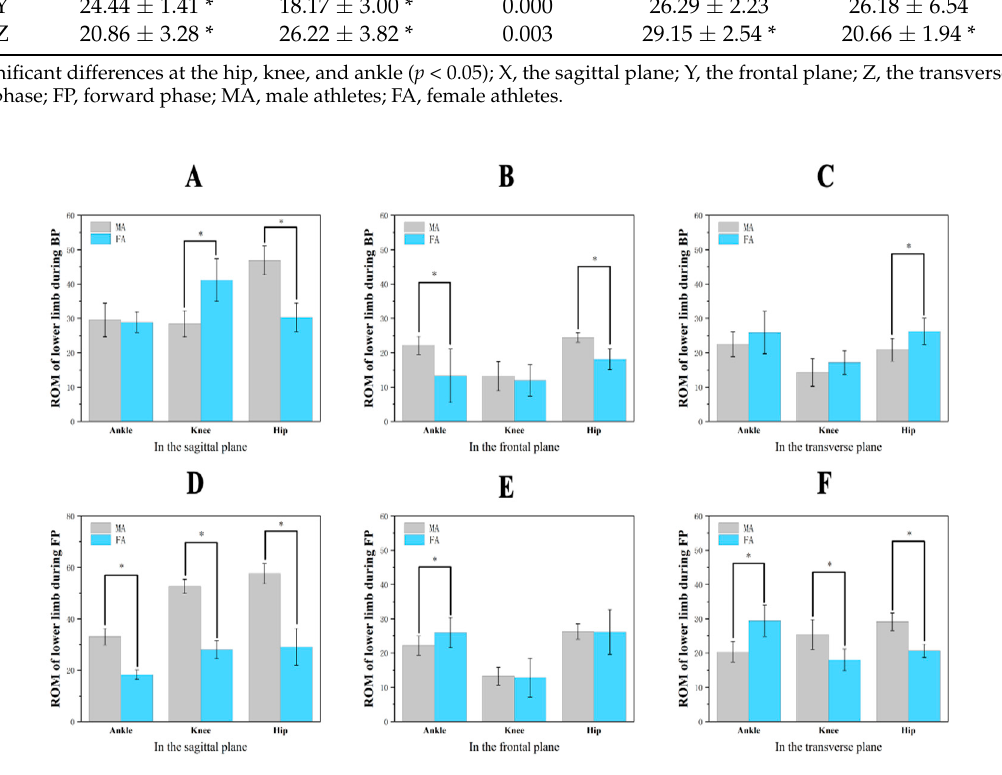
Table 4. Comparison of means ± standard deviations for ROM values in the BP and FP between MA and FA (unit: degrees). Variables